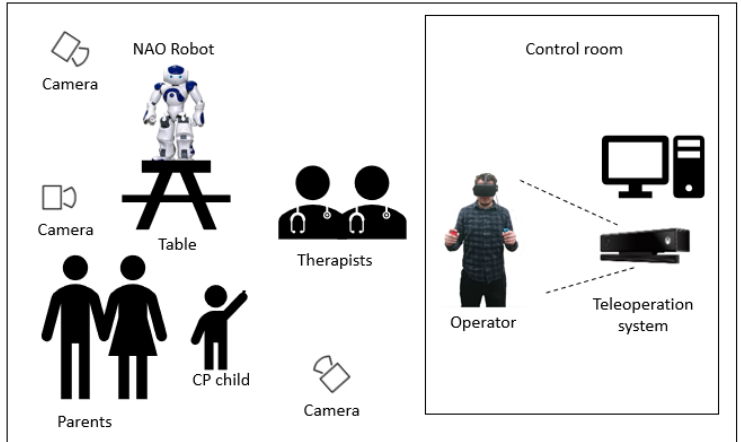
Figure 26. Draft of a room setup for the